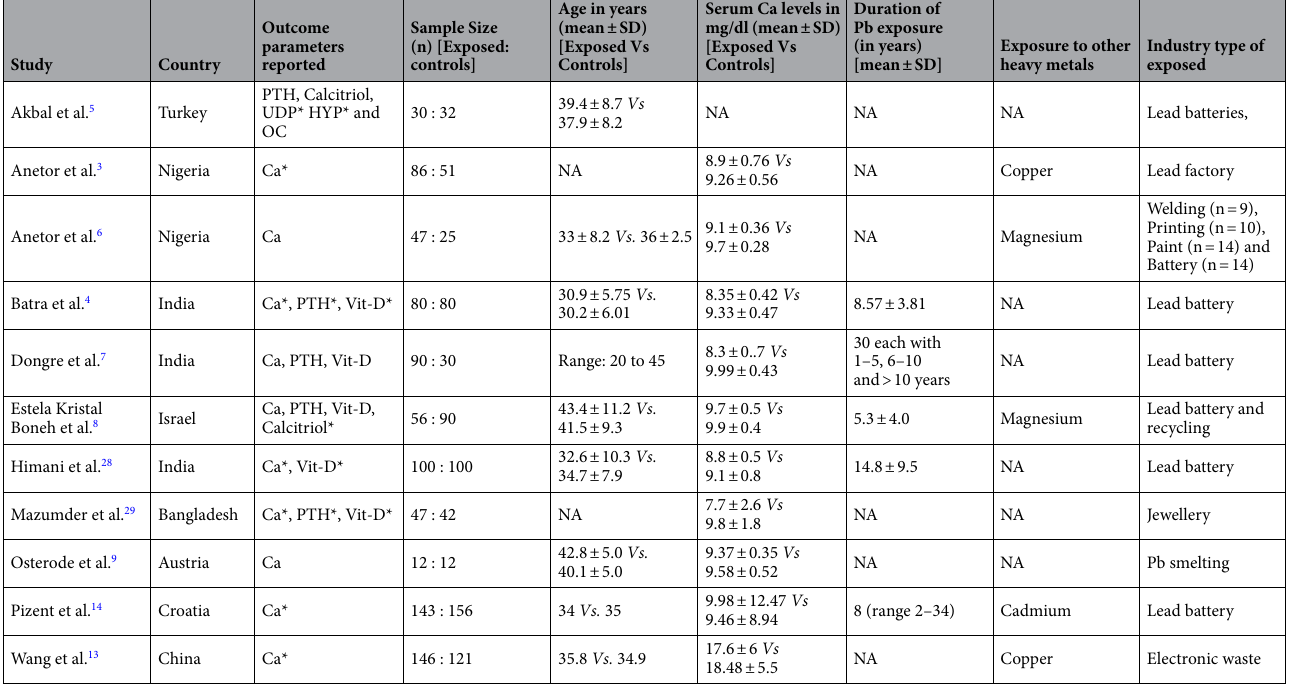
Table 1. Description of the studies. Ca Calcium, HYP hydroxyproline, NA Not available, OC osteocalcine, PTH parathyroid hormone, UDP Urinary deoxypyridinoline, Vit-D Vitamin D. *Studies reporting significant difference between the occupationally Pb exposed group and control